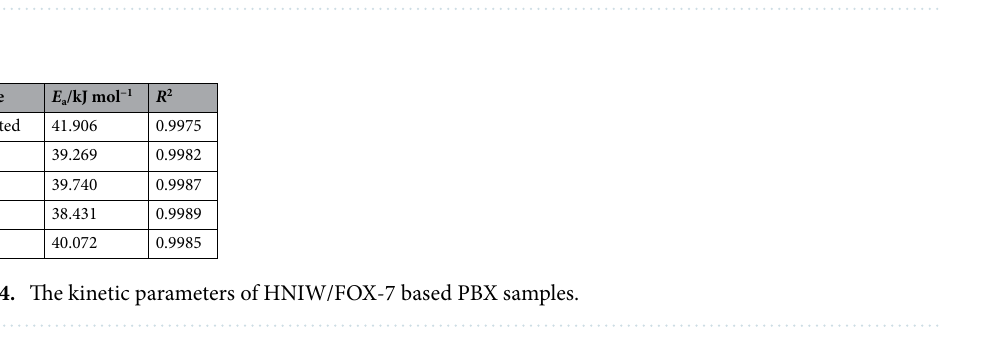
Table 3. The initial decomposition temperature ( T o ), peak temperatures ( T p ) and released heat (Δ H ) of PBX samples.